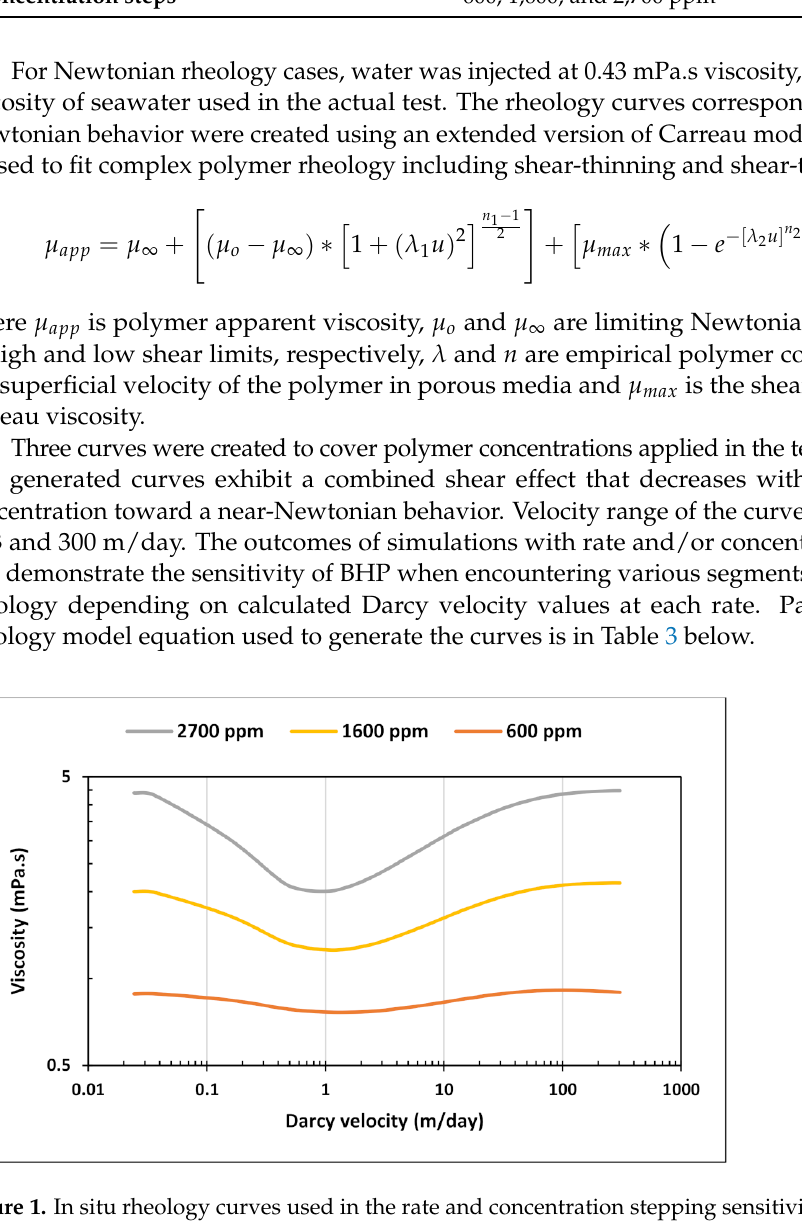
Figure 1. In situ rheology curves used in the rate and concentration stepping